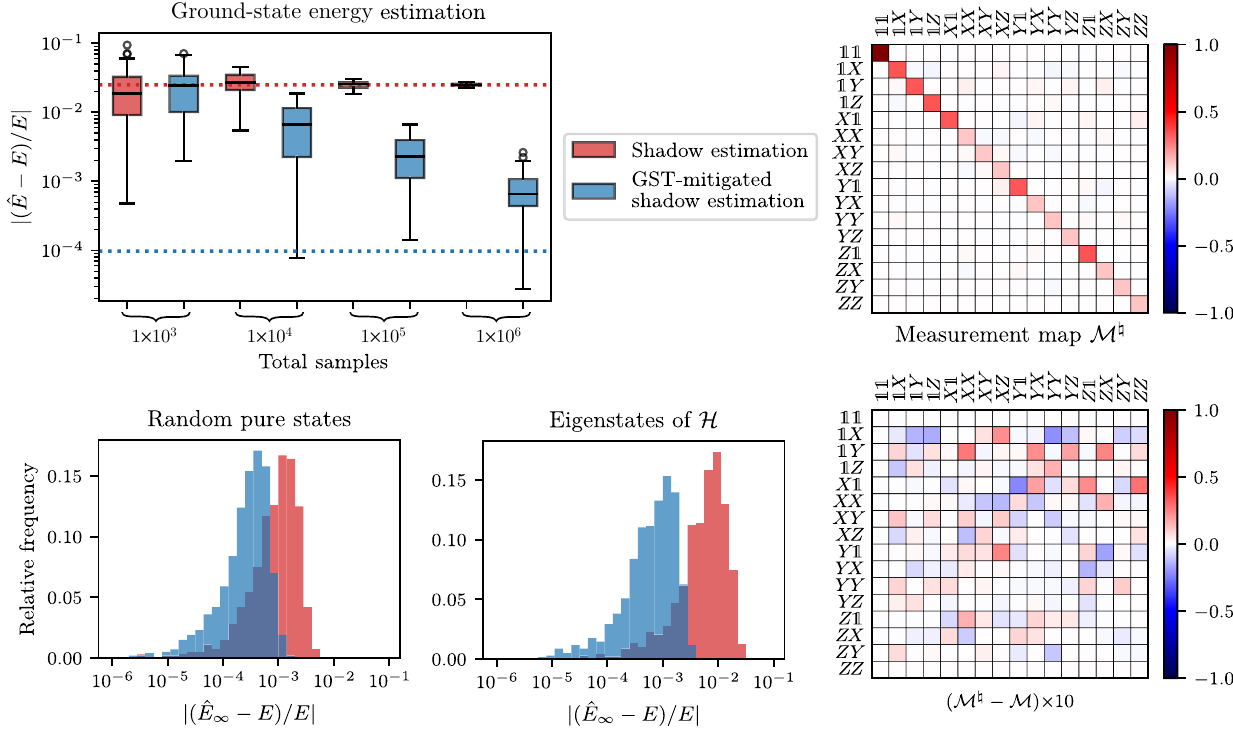
(cid:3) 10 (σ j σ j + 1 + σ j σ j + 1 + σ j σ j + 1 − σ j ) with periodic boundary x x y y z z z j = 1 2